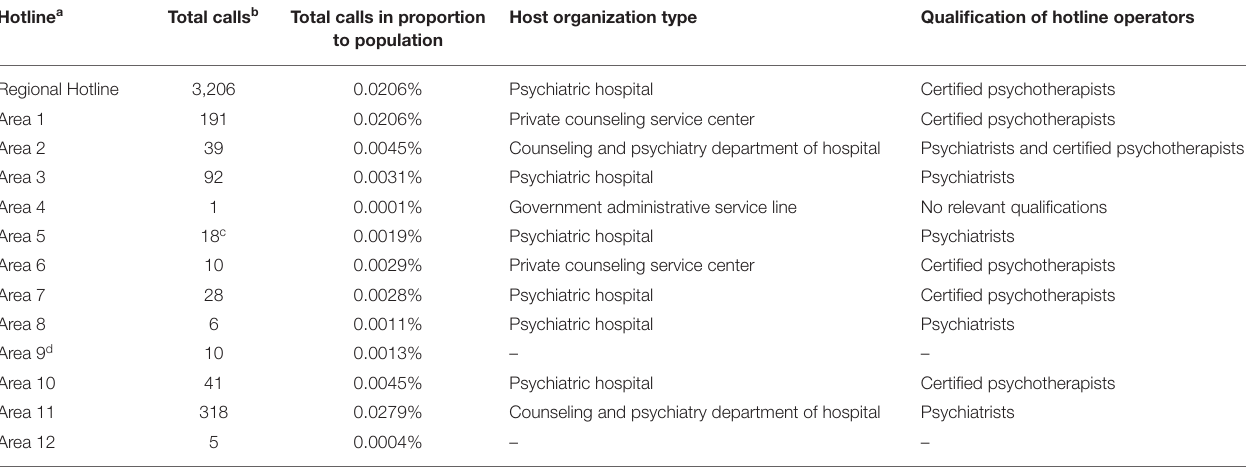
TABLE 1 | Characteristics of